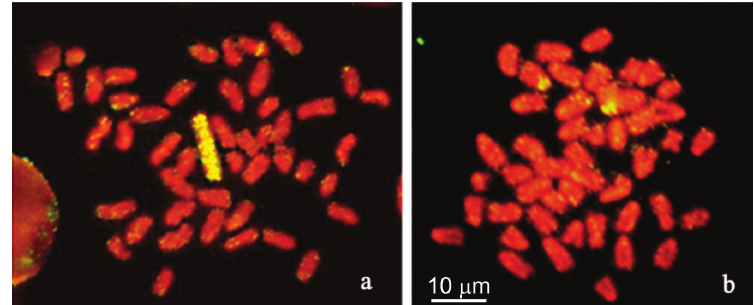
Figure 1. Mitotic chromosomes of Ch. hamatus. FISH with the Y chromosome paint on Ch. hamatus a male (2n = 47 and X1X2Y sex-chromosome system) and b female (2n = 48) metaphase spreads.